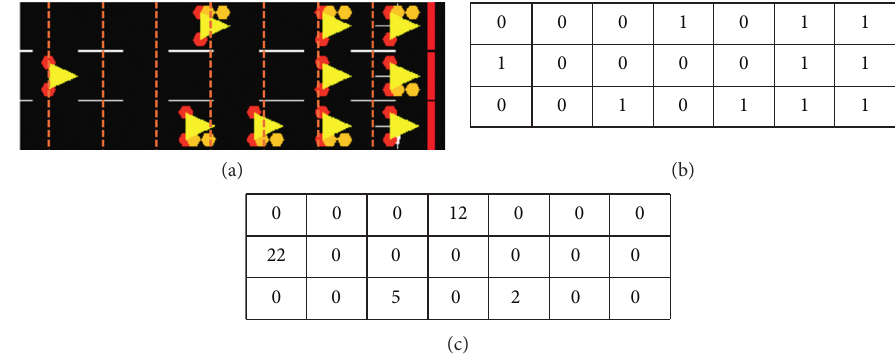
Figure 4: Example of processing maps of vehicle position and speed. (a) Simulation interface. (b) Vehicle locations. (c) Vehicle